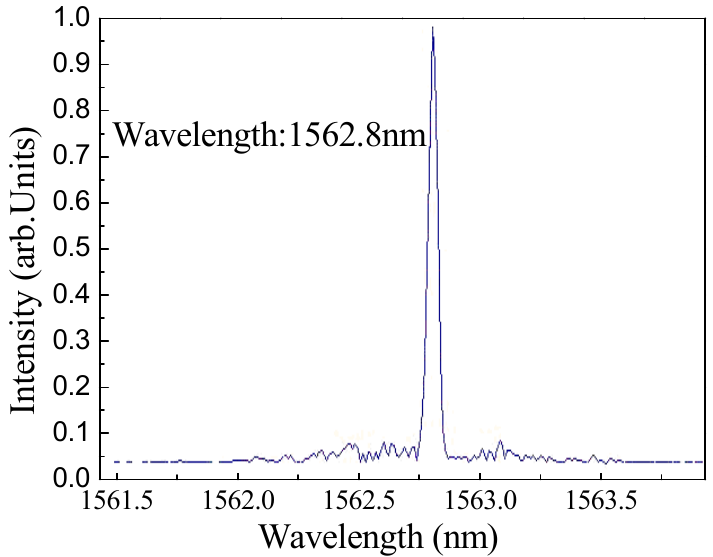
Figure 12. Output spectra of the QML fiber laser .